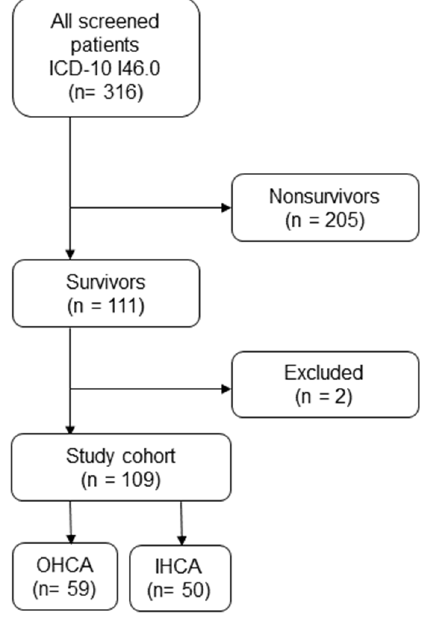
Figure 1. Study flowchart. Table 1. Demographic characteristics of 109 patients with CPR-related chest injuries.